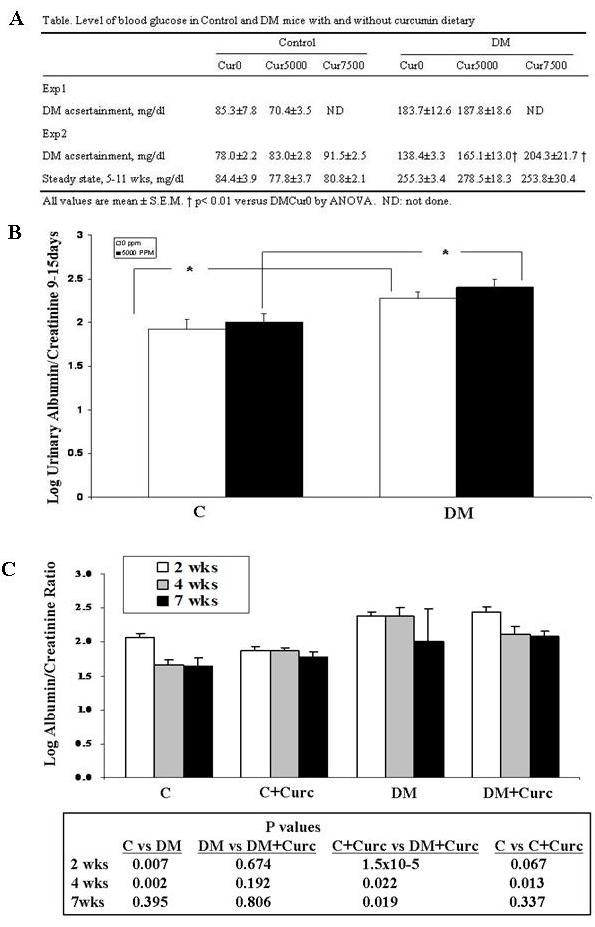
Fasting blood glucose values and effects of curcumin on DN measured by urinary albumin/creatinine in noDM and DM mice. (a) Fasting blood glucose in mice in Experiments 1 and 2. 24 h urine was collected to measure Ualb/cr in noDM and DM mice. (b) Ualb/cr from urine collected on days 9-15 for noDM and DM mice given control chow (0 ppm curcumin) or chow with 5,000 ppm curcumin. Mice were fed curcumin post-Stz injections (Experiment 1). (c) Ualb/cr at 2, 4 and 7 weeks for noDM and DM mice given control chow (0 ppm) or curcumin chow (data pooled for mice fed 5,000 and 7,500 ppm curcumin). Mice were fed curcumin pre-Stz injections (Experiment 2). All data are log-transformed (log10). *P < 0.05